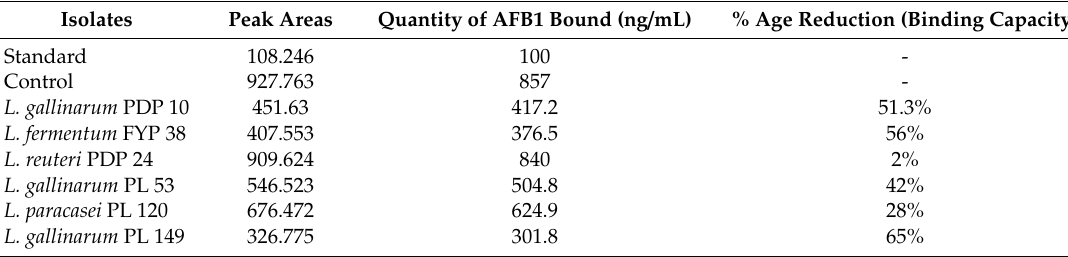
Table 3. Aflatoxin B1 binding capacity of probiotic lactobacilli.